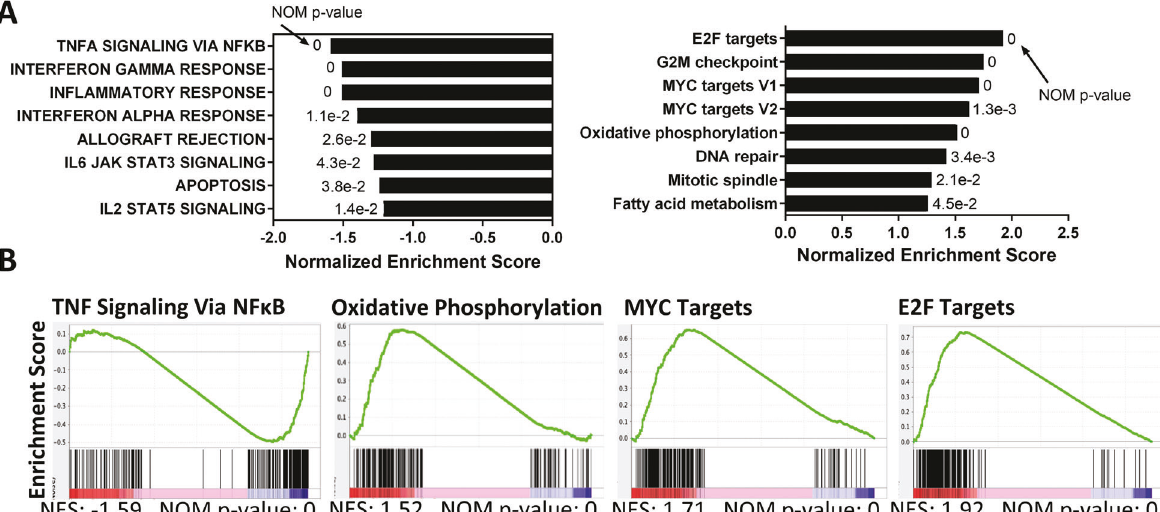
Fig. 4 Transcriptional effects of dual SYK/BTK inhibition in vivo. Spleen-resident tumor cells of the MCL-B PDX model were harvested 2 h after the fi nal treatment with CG-806 at 308 mg/kg or control as described in the methods. Gene set enrichment of RNA was calculated using gsea2 – 2.24. N = 3. A Representation of the top 8 pathways that were differentially regulated in the treatment vs. control samples. B Enrichment plots of select gene sets. Differentially regulated genes were de fi ned by log 2 fc ≥ 0.58/ ≤ − 0.58 and P adj